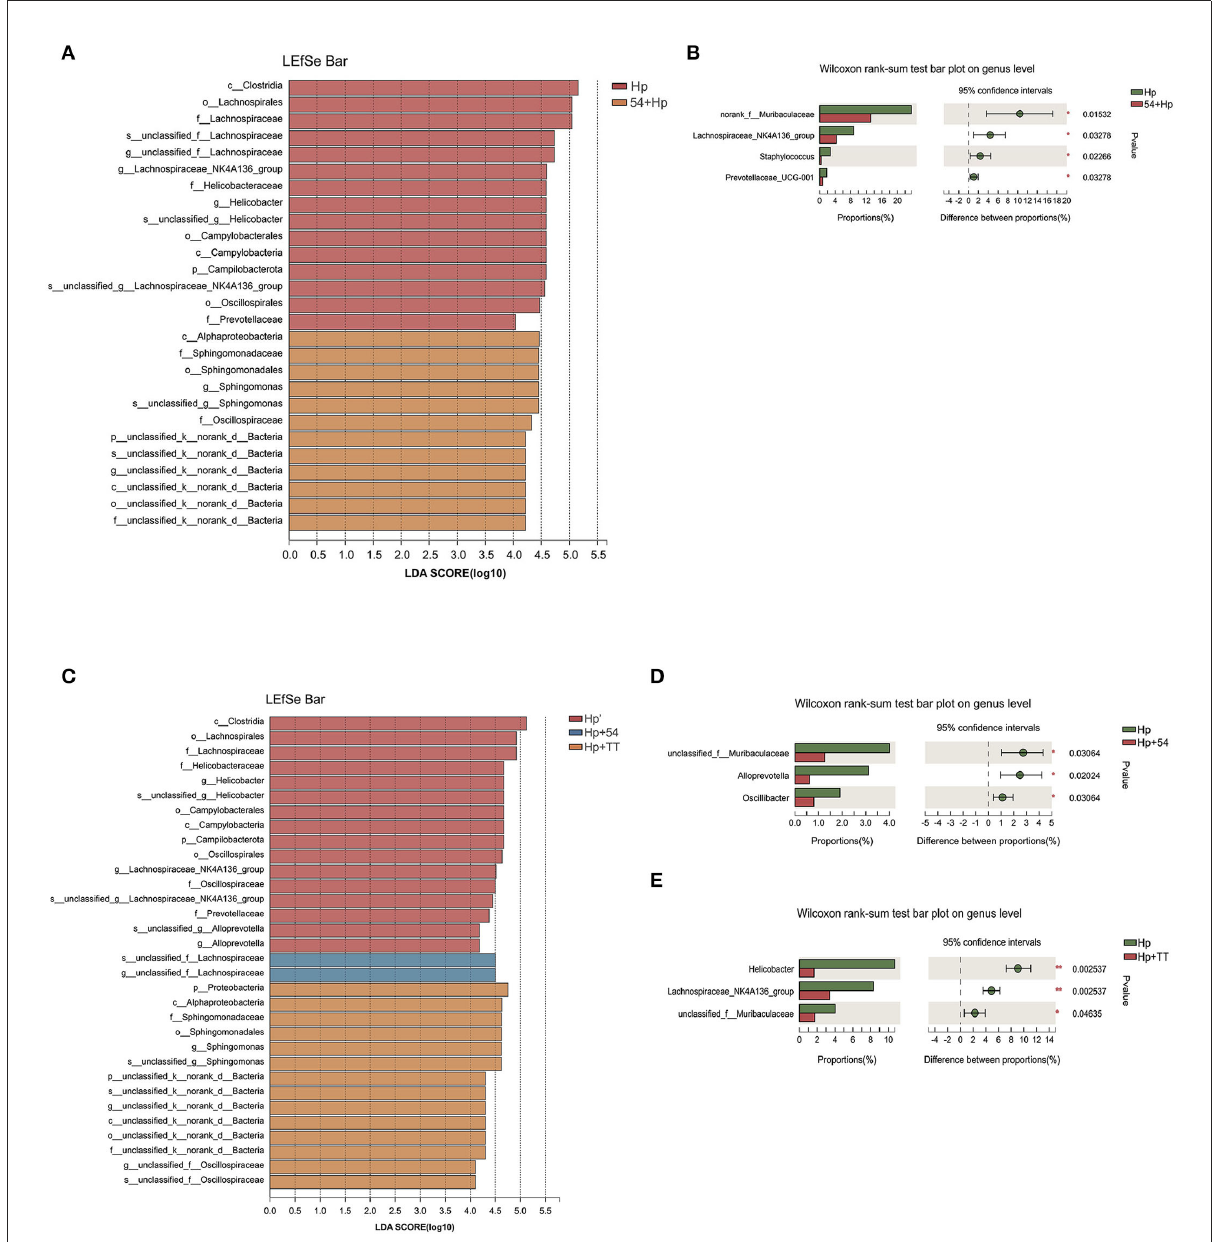
FIGURE9 Difference in bacterial taxa among preventive and therapeutic groups. (A) Bacterial taxa significantly differentiated among the preventive group identified by the linear discriminant analysis (LDA). (B) Bacterial communities with significant relative abundance differences at the genus level between Hp and 54 + Hp groups by the Wilcoxon rank-sum test ( n = 6). (C) Bacterial taxa significantly differentiated among the therapeutic group by LDA. (D) Bacterial communities with significant relative abundance differences at the genus level between Hp and Hp + 54 and Hp and Hp + TT groups by the Wilcoxon rank-sum test ( n = 6). Only taxa meeting an LDA significance threshold of > 4 were shown, * p < 0.05, ** p < 0.01.